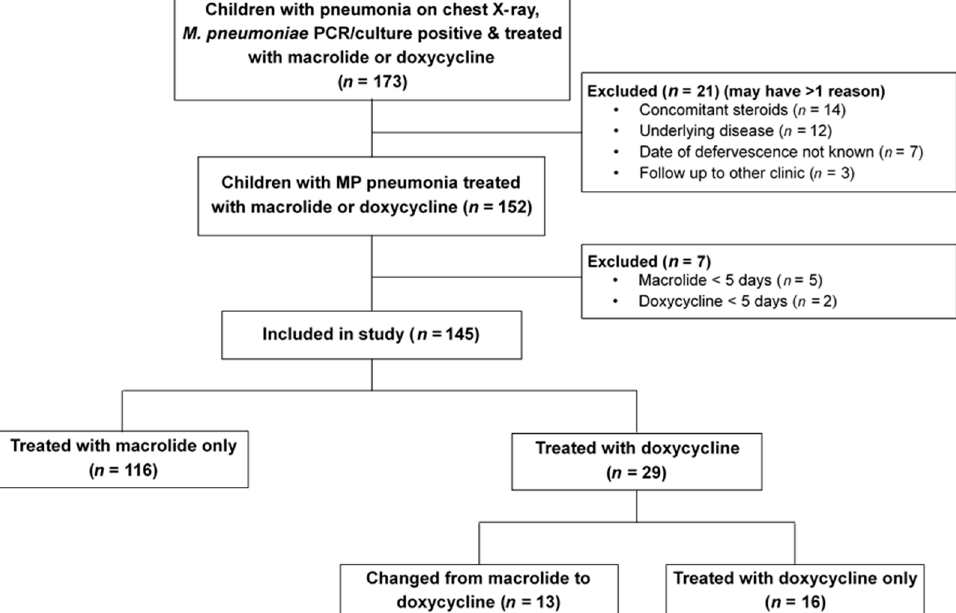
Figure 1. Flow diagram of cases included in the study for comparison of antibiotic response between macrolides and doxycycline in children with Mycoplasma pneumoniae pneumonia according to macrolide resistance. MP, Mycoplasma pneumoniae.